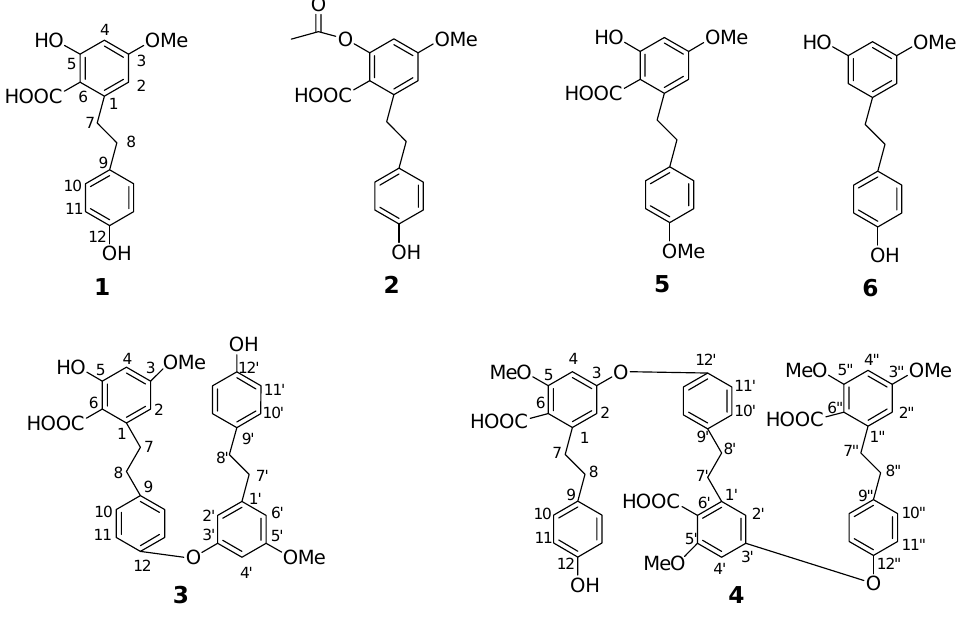
Figure 1. Compounds 1 - 6 from Notholaena nivea